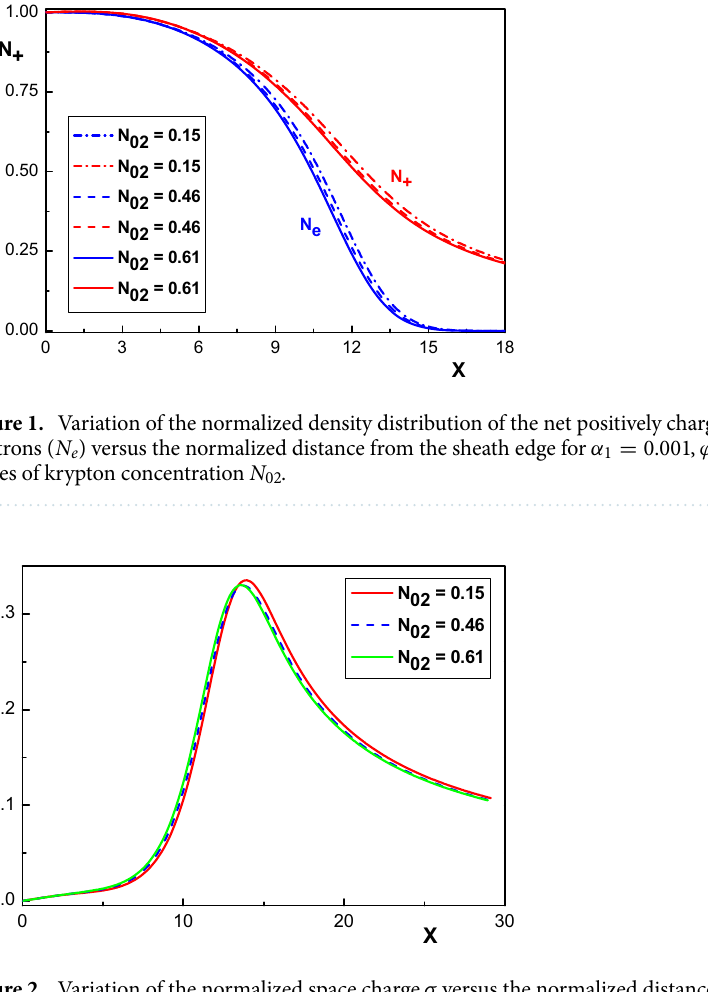
Figure 2. Variation of the normalized space charge σ versus the normalized distance from the sheath edge for different krypton concentrations. The other parameters are the same with Fig.